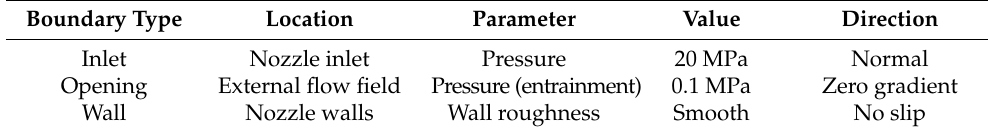
Table 2. Boundary condition setting.